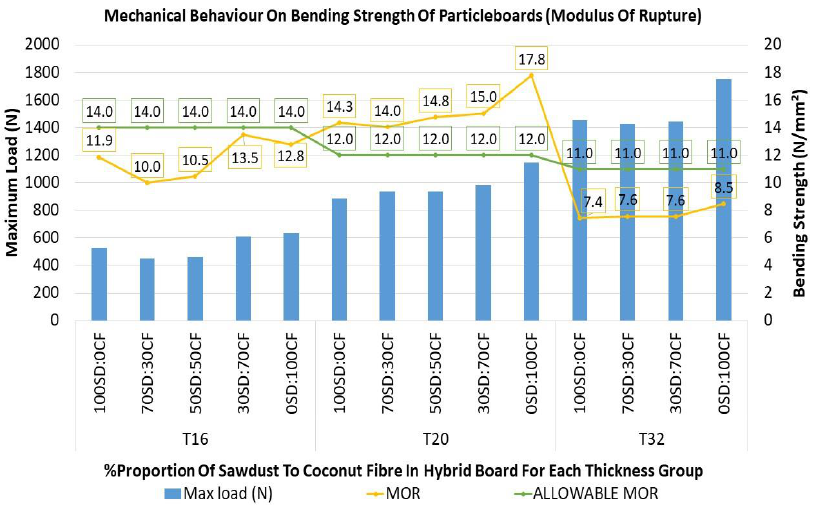
Figure 16. Mechanical Performances on the Bending Strength of Particleboards (Modulus of Rupture)